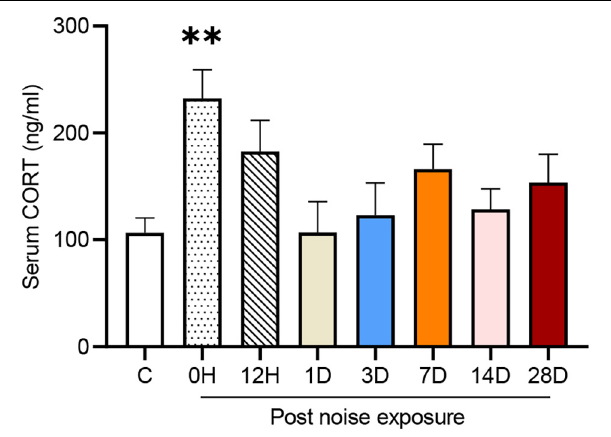
FIGURE 2 | Noise-exposed mice exhibited an early but transient increase in serum corticosterone (CORT). The values are presented as the mean ± SEM of 6–8 mice per group. ∗∗ p < 0.01 in the post hoc comparisons between the noise group and the controls after one-way